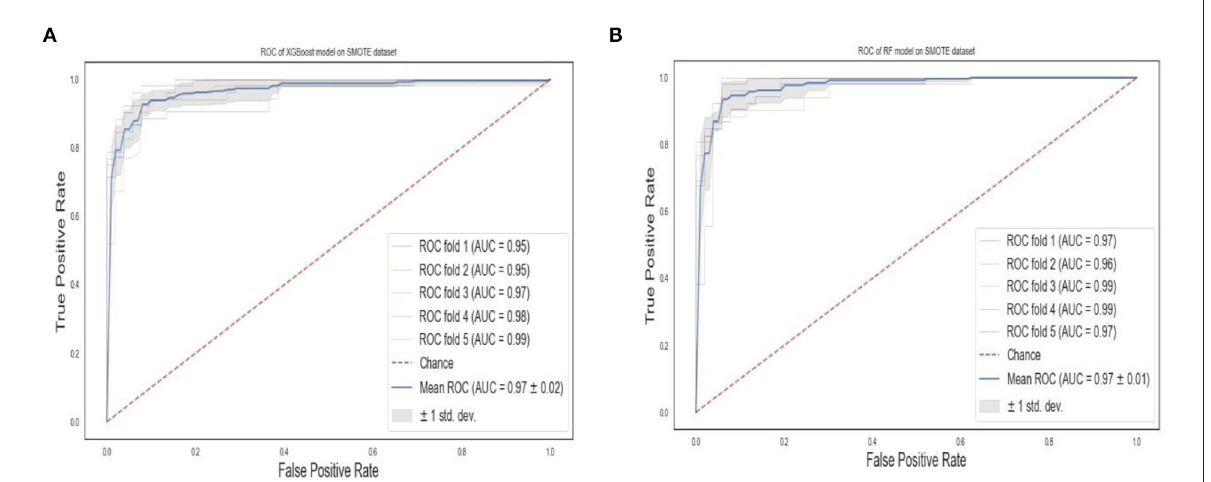
FIGURE8 ROC curves of XGBoost and random forest on the SMOTE dataset. (A) XGBoost. (B) RF.